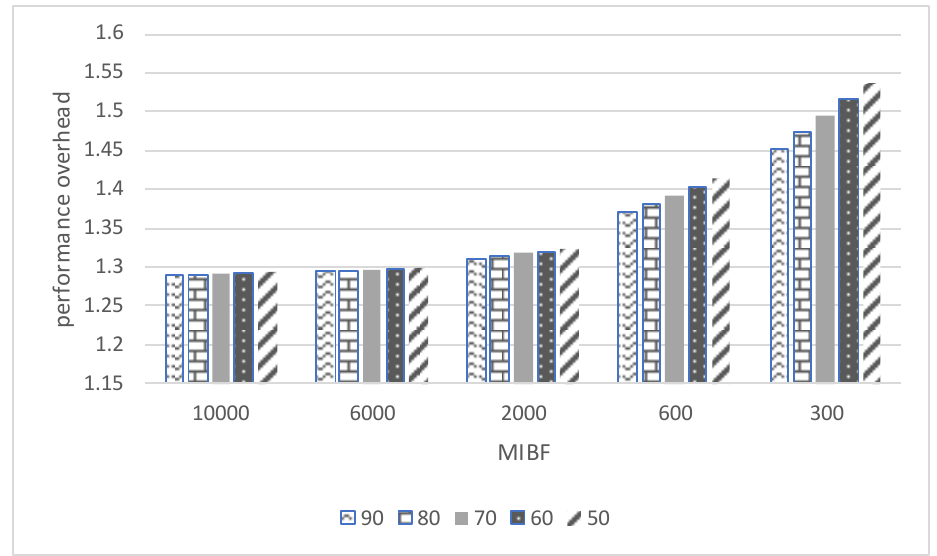
Figure 10. Performance overhead on breadth first search benchmark with various prediction probability.